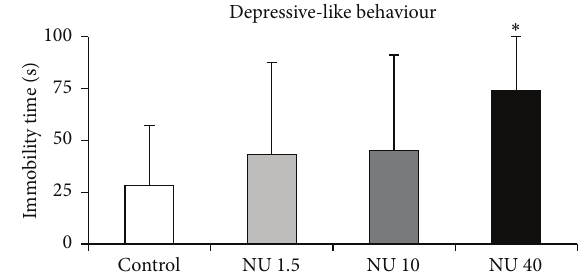
Figure 5: Depressive-like behaviour of male rats exposed to 1.5, 10, or 40mg ⋅ L −1 NU from birth for 9 months. Time of immobility is expressed in seconds and reflects the depression level. The data are presented as mean ± SEM; 𝑛 = 12 for each group; NU: natural uranium; ∗ 𝑝 < 0.05 , significant difference from